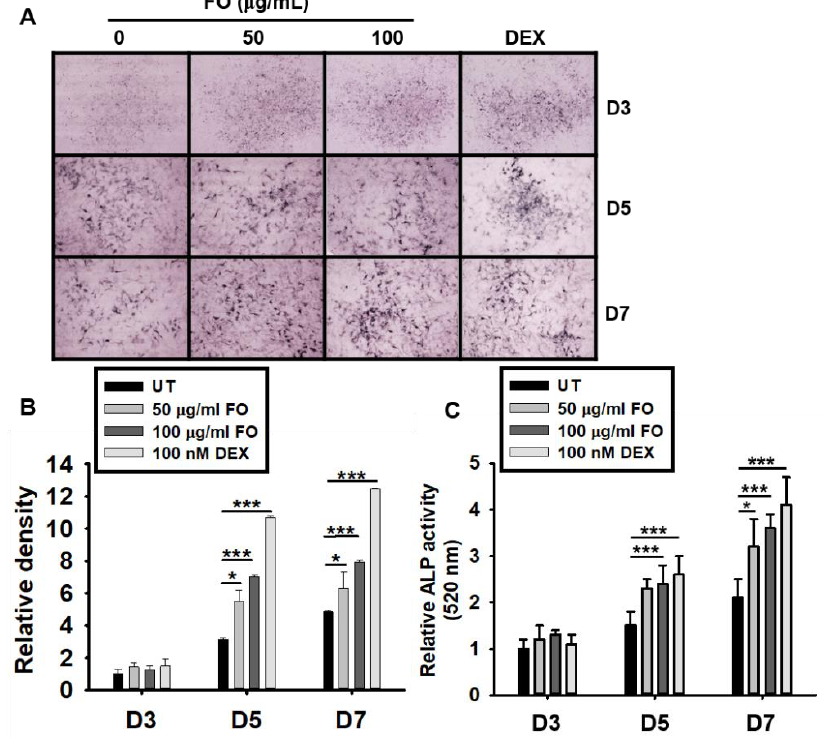
Figure 3. FO upregulates ALP expression and activity in preosteoblast MC3T3-E1 cells. ( A ) MC3T3-E1 cells were treated with FO (50 µg/mL and 100 µg/mL) or DEX (100 nM) for 7 days. Representative images from three biological replicates were collected using the Toup View software after staining the cell for ALP activity (as described in the Materials and Methods section) on day 3 (D3), day 5 (D5), and day 7 (D7). ( B ) The relative ALP staining density was represented using mean integrated pixel density. ( C ) ALP activity was measured at 520 nm using a tartrate-resistant acid phosphatase (TRACP) & alkaline phosphatase (ALP) assay kit. Significant differences among the groups were determined using the one-way ANOVA followed by Bonferroni correction. All data are presented as mean ± SEM (*** p < 0.001 and * p < 0.05 versus untreated group). FO; fermented extract of C. gigas and DEX; dexamethasone.